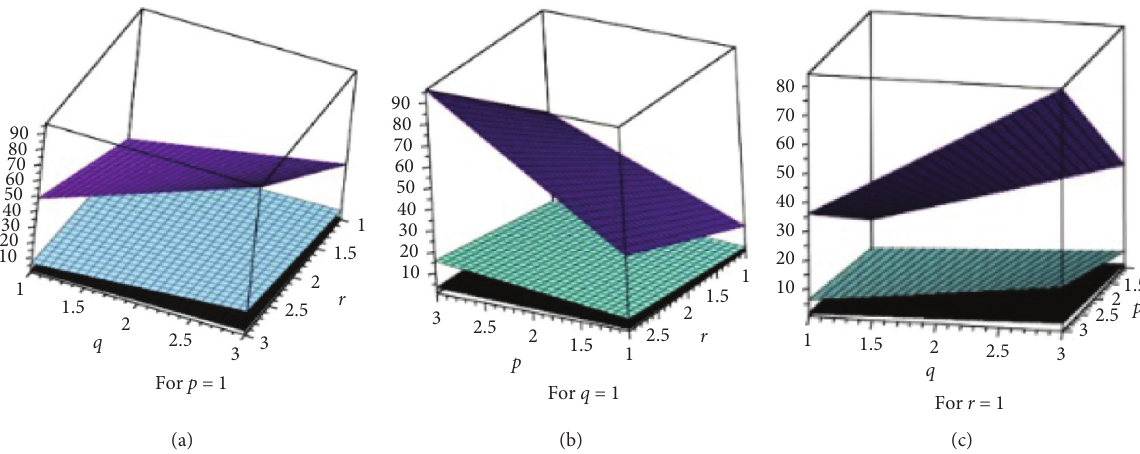
Figure 8: Comparison of IRA , IRB, and IRDIF for crystallographic structure Cu